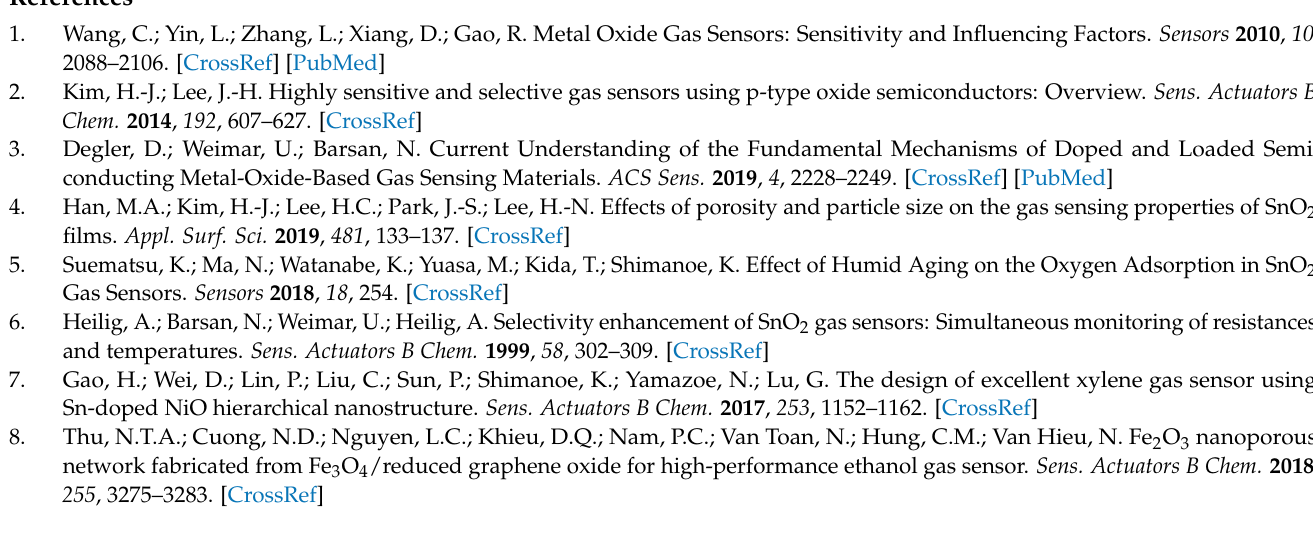
Supplementary Materials: The following are available online at https://www.mdpi.com/1424-8 after annealing process. Figure S2: Schematic diagram of a custom-built experimental apparatus for controlling humidity. Figure S3: Real time data of bare ( a ) and PFOTS coated porous SnO 2 film gas sensors ( b ) are obtained at relative humidity 0, 20, 40, and 70 %. Figure S4: Gas sensor sensitivity with removing effect of humidity. ( a ) Bare and ( b ) PFOTS shows sensitivity according to amount of CO; the reaction gas (R g ) with the humid air signal (R (a+RH) ). The trend line is drawn with R 2 at RH 0%. Figure S5: Photos of the gas sensor platform. ( a ) Front image of patterned Pt electrodes and ( b ) back image of heater. ( c ) Schematic image of the porous SnO 2 gas sensor